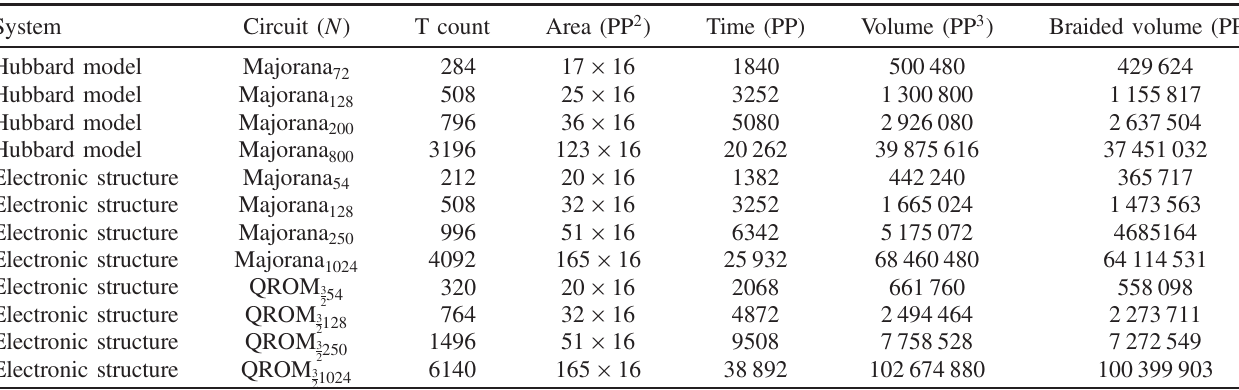
TABLE VIII. Automatically generated resource estimates of the Majorana and QROM circuits (Figs. 9 and 10). The area width, height, and time columns give the dimensions of the bounding box (e.g., Fig. 25) in units of plumbing pieces. The last column is the number of plumbing pieces estimated to be actively used within the bounding box. The volume numbers do not include the volume of the T factory, but they do include idle qubits that are present in the algorithm as a whole but not the individual circuits. “ Braided volume ” refers to the amount of actively used volume, i.e., nonempty space with defects used to encode qubits and operations. QROM circuits are indexed like QROM 3 because, in context, the QROM index size L is always 50% larger than the number of orbitals N 2 N